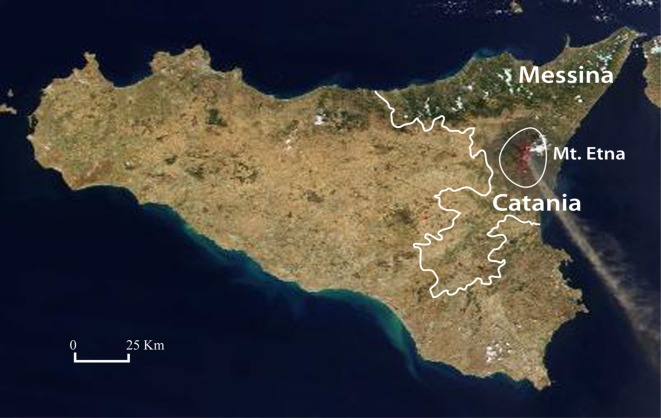
Map of Sicily. The two provinces (Catania and Messina) closer to the MT. Etna volcano are indicated.